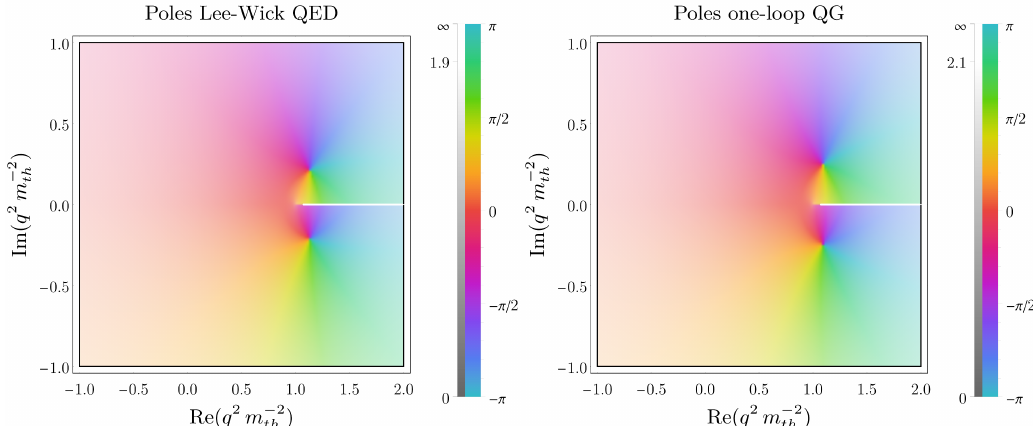
Figure 15 . Pole structure of the propagator in the complex q 2 -plane, in the case of Lee-Wick QED (left panel) and one-loop QG (right panel), for α = β = 1 . As is evident from the plots, the two theories share very similar features: they both develop complex-conjugate poles (entailing a violation of causality) and a single branch cut, associated with an unstable ghost degree of